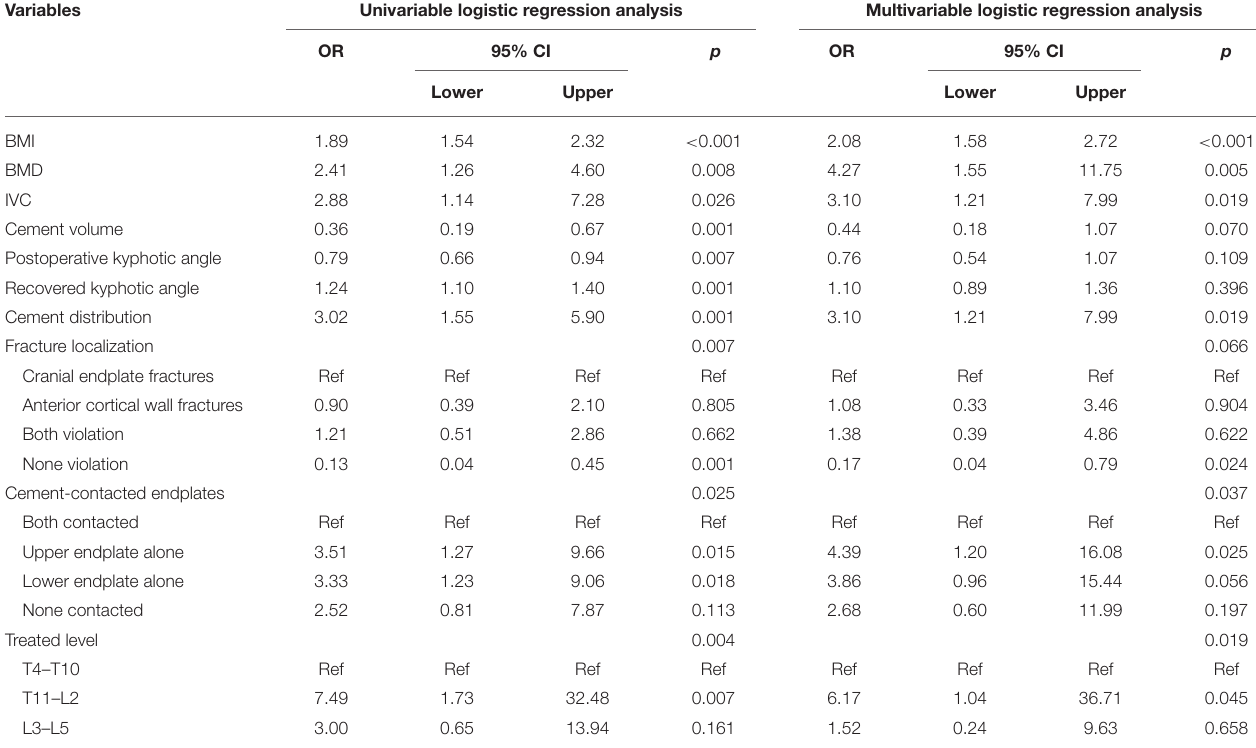
TABLE 3 | Univariate and multivariate logistic regression analysis for the risk factors of postoperative recollapse after percutaneous kyphoplasty (PKP). Variables Univariable logistic regression analysis Multivariable logistic regression analysis